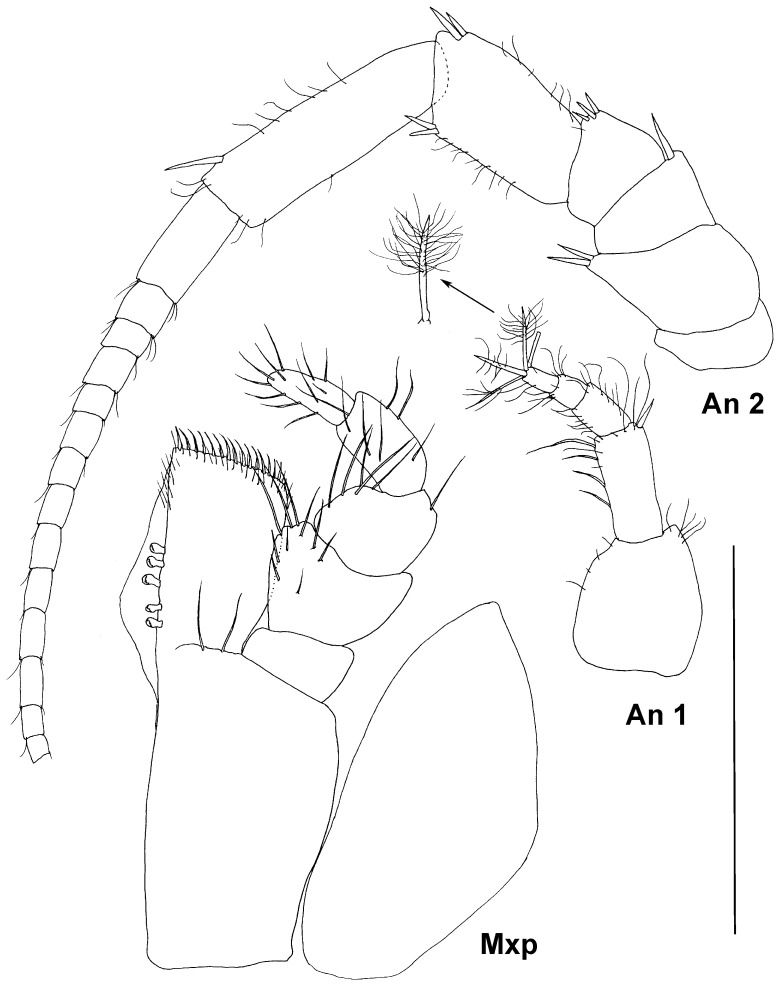
Paratype ZMH K-44089, female, antennula, maxilliped, scale – 0.5 mm.